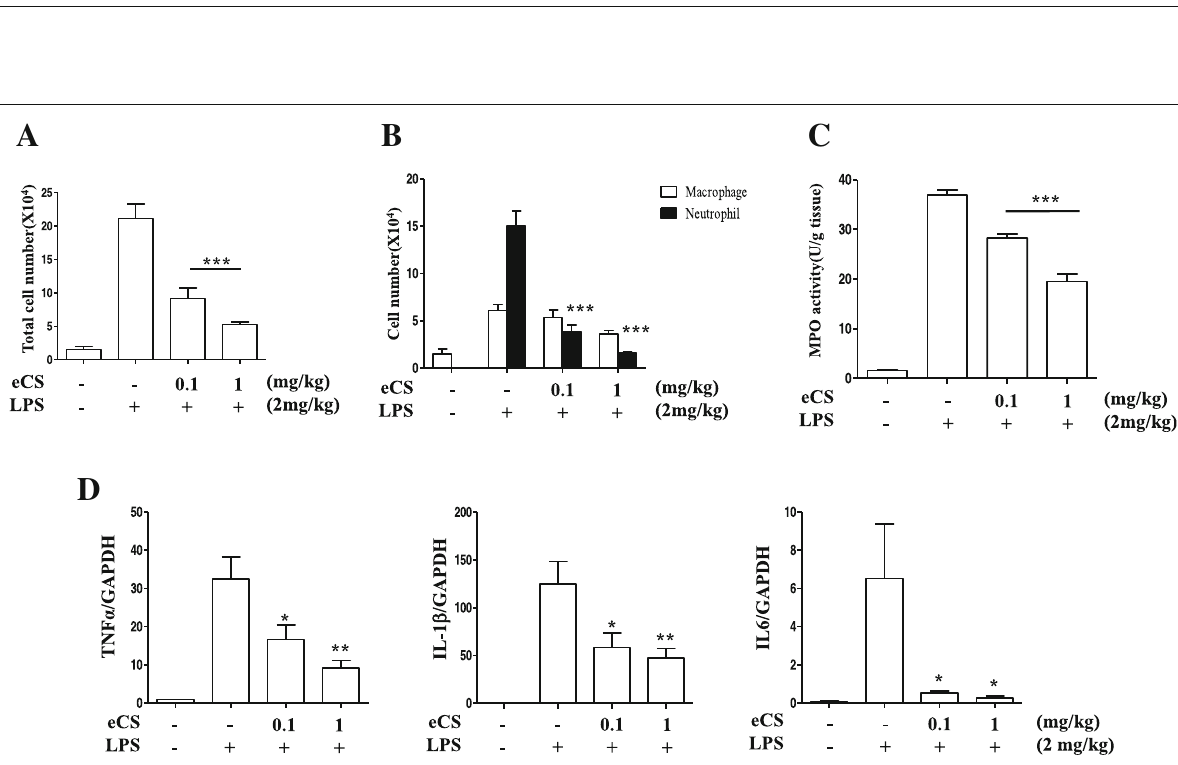
Fig. 7 Intratracheal eCS suppresses neutrophil infiltration in mouse lungs. Bronchoalveolar lavage (BAL) was performed with C57BL/6 mice (n = 5/ group) treated as in Fig. 5. Total cells ( a ) and macrophages (open columns) and neutrophils (closed columns) ( b ) were counted in the BAL fluid. *** P was less than 0.0001, compared to the mice treated with LPS only. c After perfusion, lung lysate was prepared, with which MPO activity was measured. *** P was less than 0.0001, compared to the mice treated with LPS only. Data are presented as the mean ± SEM of 5 mice per group. d Total RNA was extracted from the lung, with which expressions of IL-6, IL-1 β , and TNF- α were analyzed by a real-time quantitative PCR. *P and **P were less than 0.05 and 0.001, respectively, compared to the mice treated with LPS